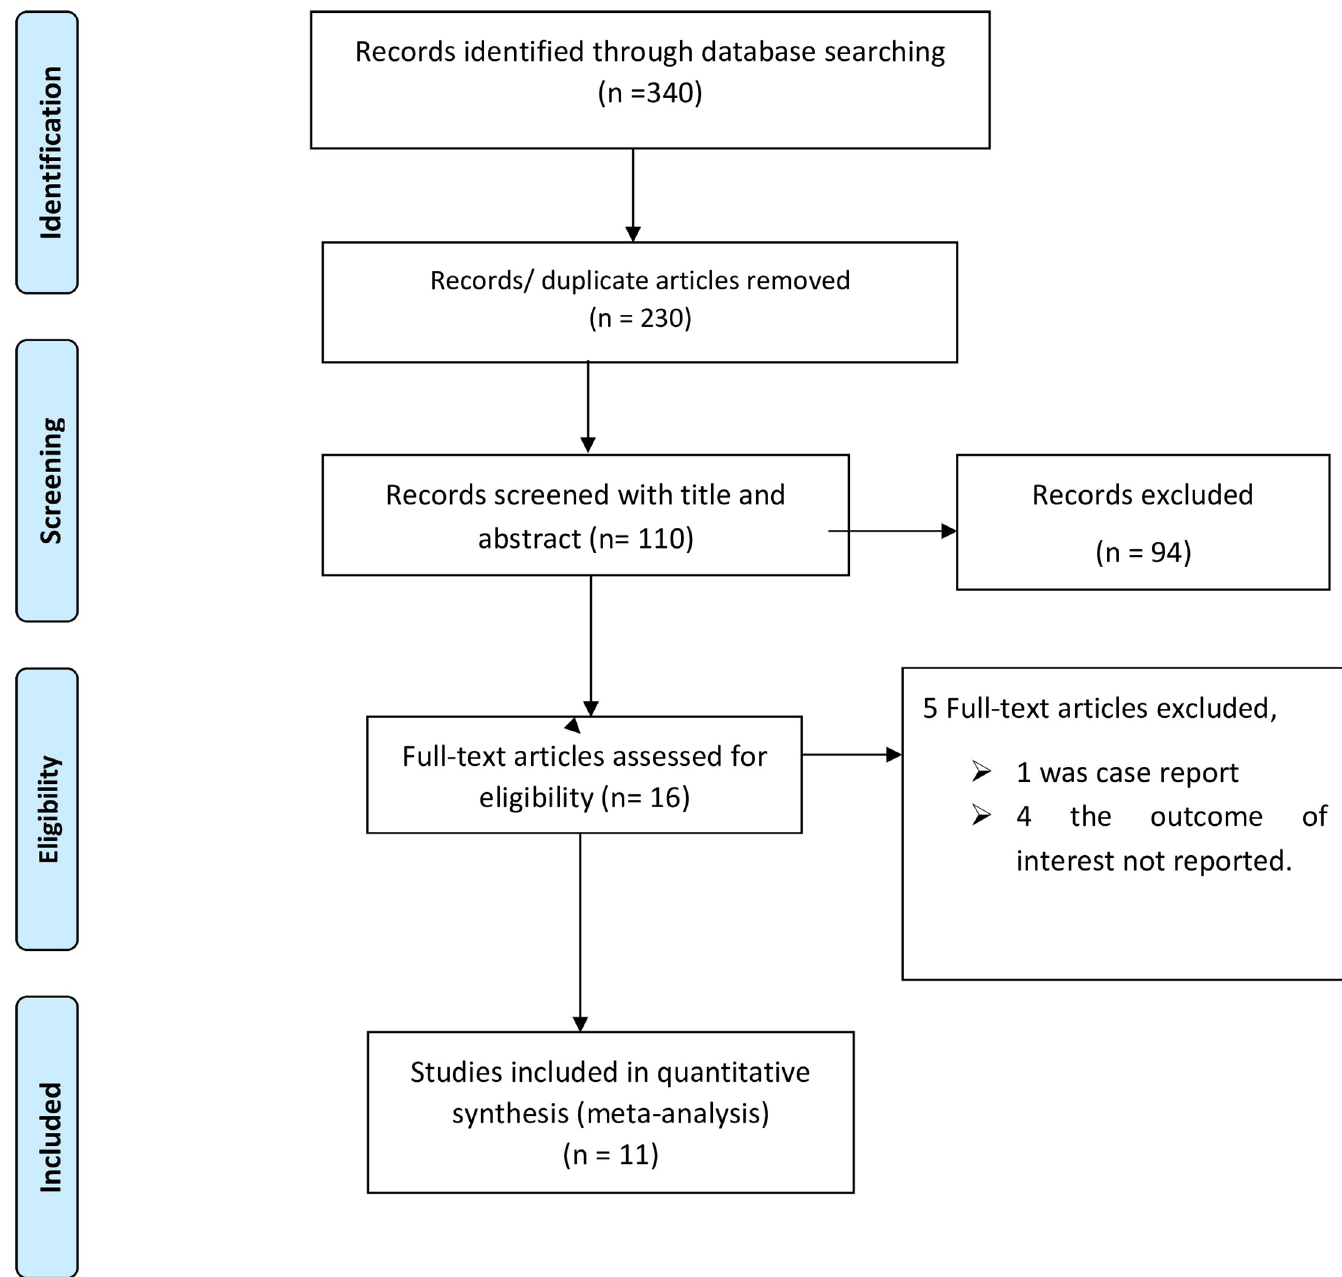
Fig 1. PRISMA flow diagram of maternal and perinatal mortality of uterine rupture in Ethiopia.